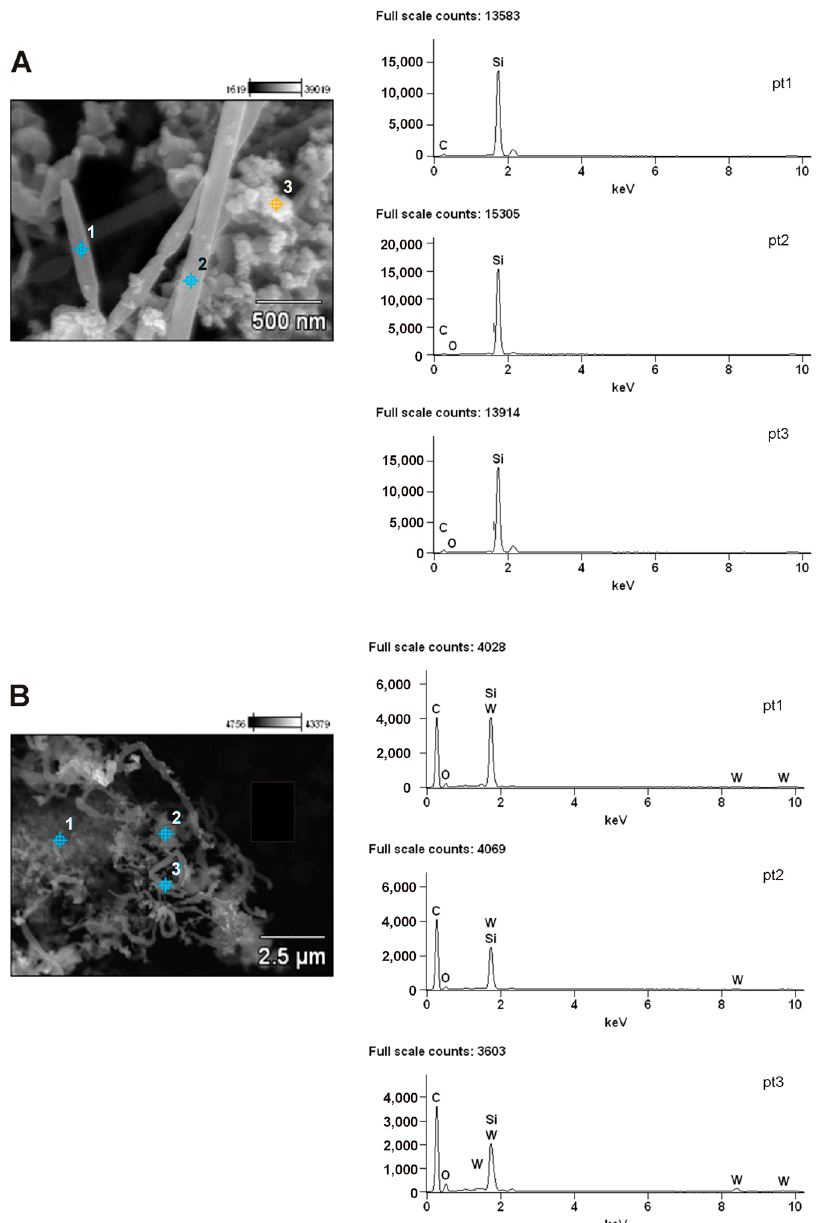
Figure 4. SEM/EDS analysis of the W x C- β -SiC nanocomposites obtained by thermal reduction of a mixture of WO 3 and SiO 2 by graphitized carbon at 1550 ° C for 1.5 h: ( A ) SEM and EDS spectra of β -SiC catalyst and ( B ) SEM and EDS spectra of β -SiC catalyst. (The numbers in round (5) W x C- (10) W x C- brackets (5) and (10) show the amounts of W in the catalysts).